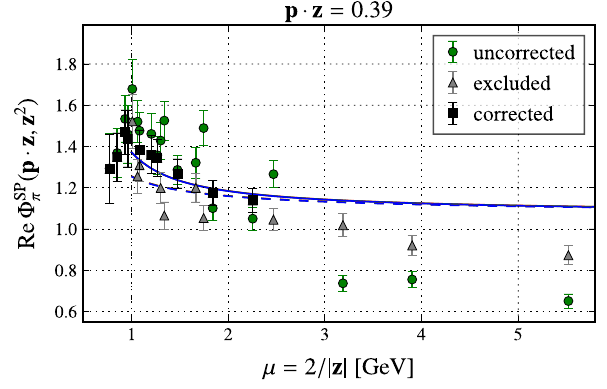
Fig. 5 Correction of discretization effects for the example of a fixed p · z = 0 . 39 and | p | = 1 . 08GeV. Points with a correction larger than 10% (gray triangles) will be ignored in the analysis